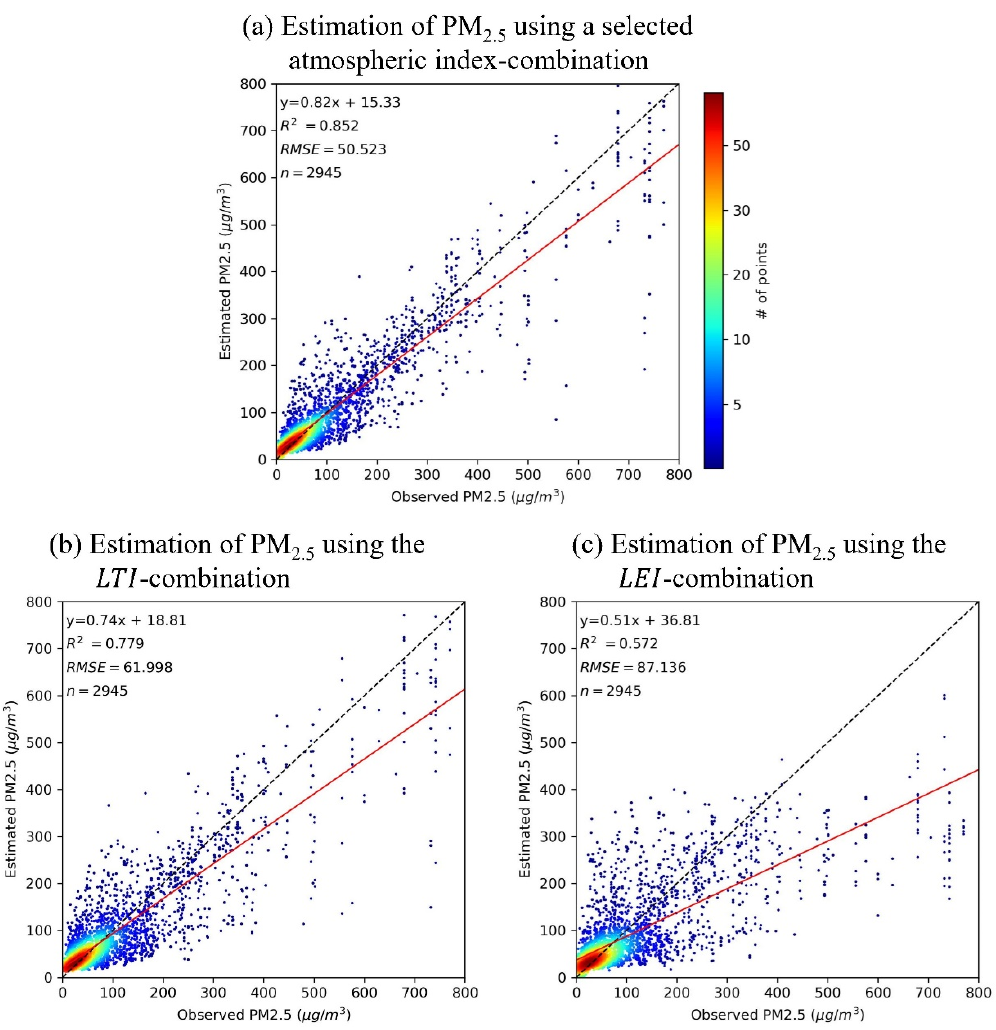
Figure 5. Density scatterplots of cross-validation (CV) for PM 2.5 estimation. ( a ) The CV results for a selected atmospheric index combination. ( b , c ) The CV results for LTI -combination and LEI - combination. The solid red line is the fitted linear regression model and dashed black line, 1:1.